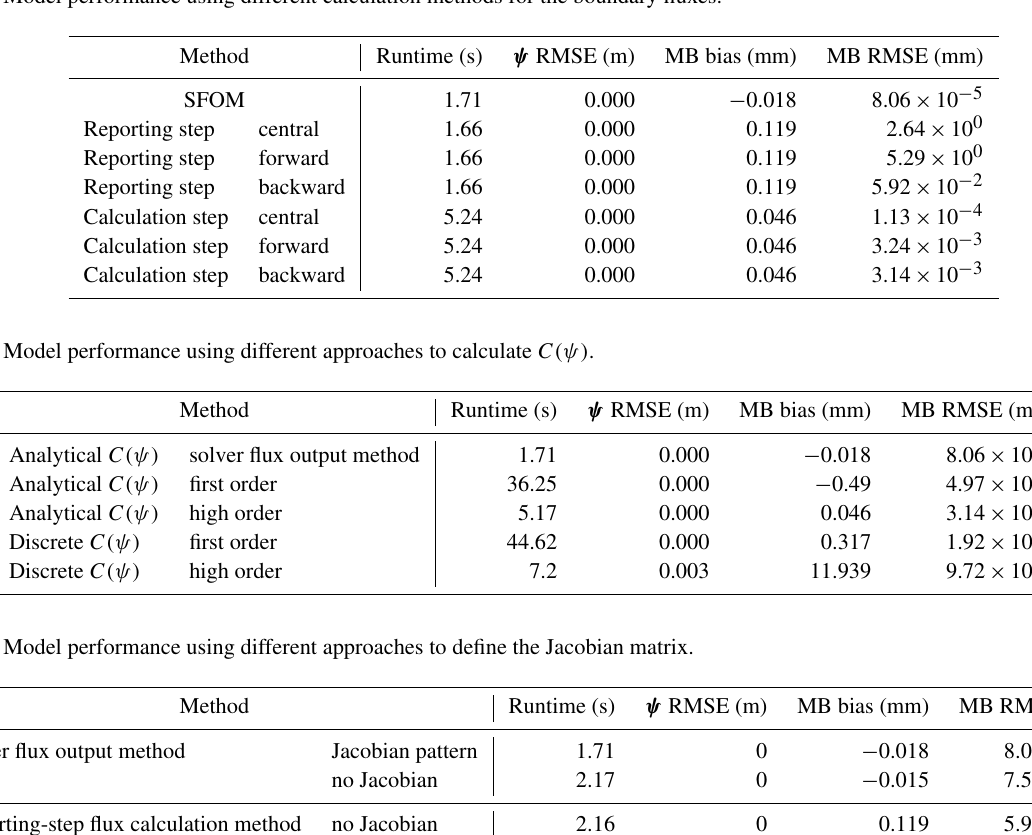
Table A2. Model performance using different calculation methods for the boundary fluxes.